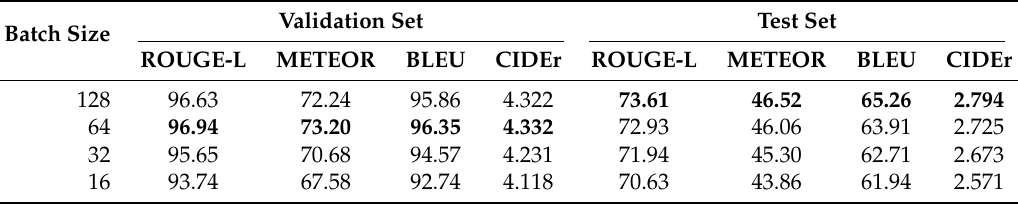
Table 9. Effects of the batch size on sign language translation